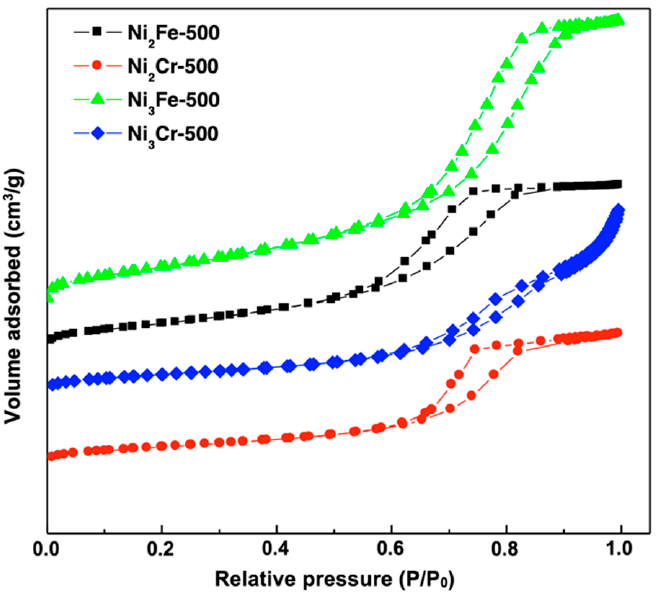
Figure 8. N 2 adsorption–desorption isotherms of Ni R Cr-500 and Ni R Fe-500 catalysts. As can be seen in Table 3, the textural parameters of the solids follow the same trend; i.e., the values of BET surface area, pore volume, and pore diameter show a progressive increase with increasing Ni to trivalent metal ratios. The specific surface areas of Ni R Fe are approximately two times greater than that of Ni R Cr. The highest specific surface area value of Ni 3 Fe catalyst (160 m 2 /g) is in accordance with the smallest respective crystallite size (53 Å, Table 3).